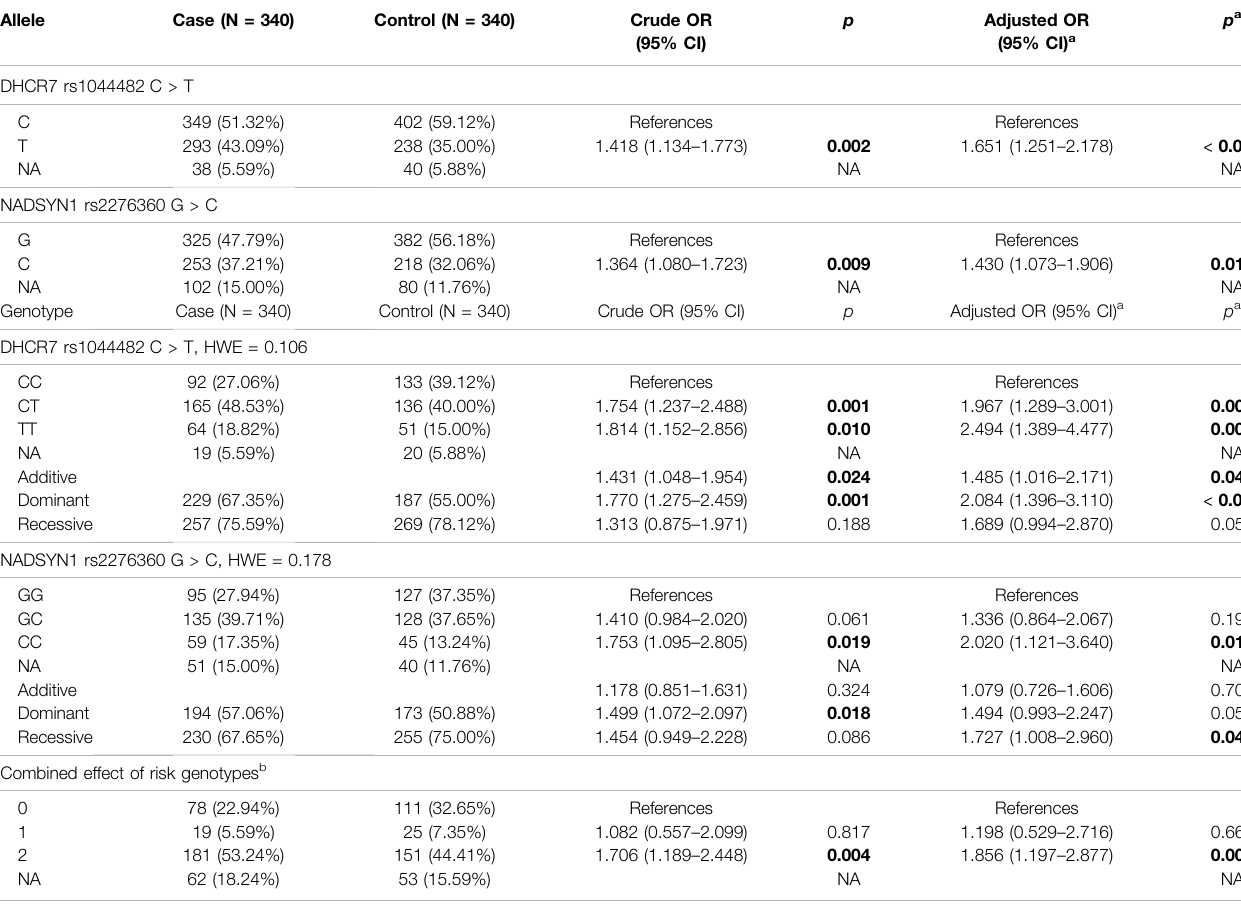
TABLE 3 | Association between the two SNPs and ULs by logistic regression analyses. Allele